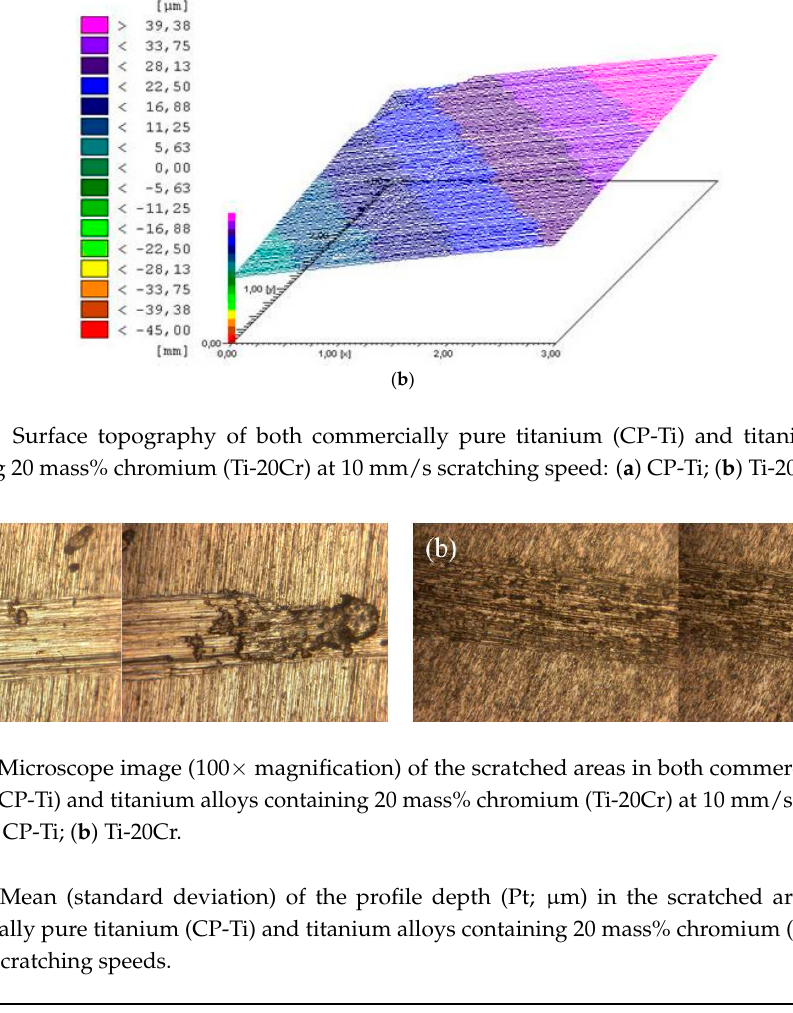
Titanium alloys containing 20 mass% chromium (Ti-20Cr) Results of statistical analysis are represented by lower and upper case letters. Different lowercase letters in the same column indicate that the groups are significantly different ( p < 0.05). Different upper case letters in the same row indicate that the groups are significantly different ( p < 0.05).